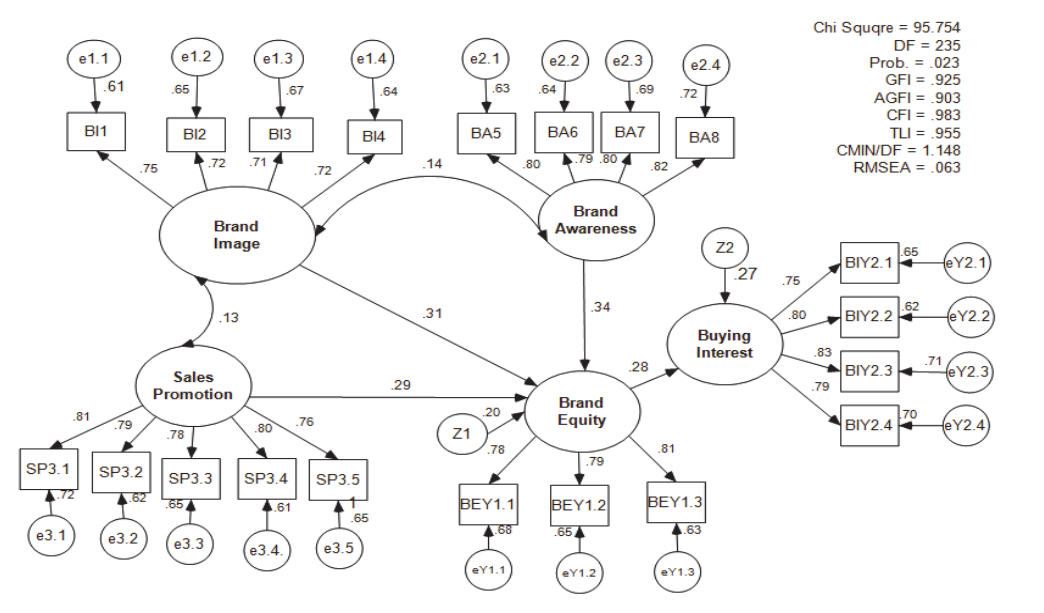
Fig. 1. Full Structural Model Parameter Assessment Results from Research